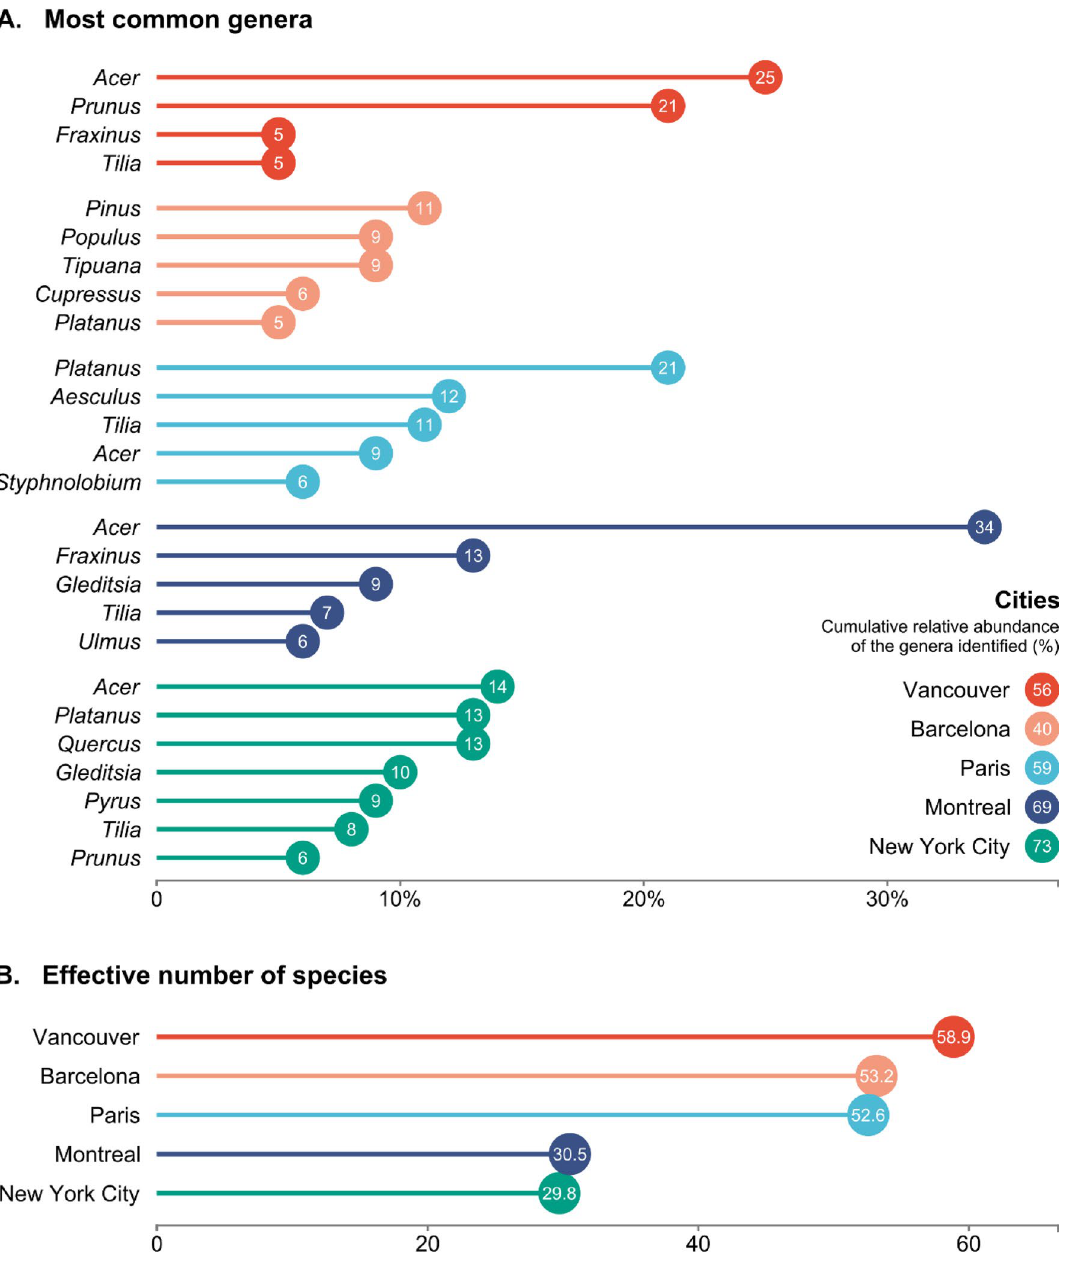
Figure 3. Relative abundance of the most common genera ( A ) and the effective number of species ( B ) in each of the studied cities based on the total number of public trees. For simplicity, only genera with a relative abundance greater than 5% are identified. Cities are ranked by their effective number of species, which is used as a measure of species diversity, with higher values indicating greater diversity. For more data, see Supplementary Table